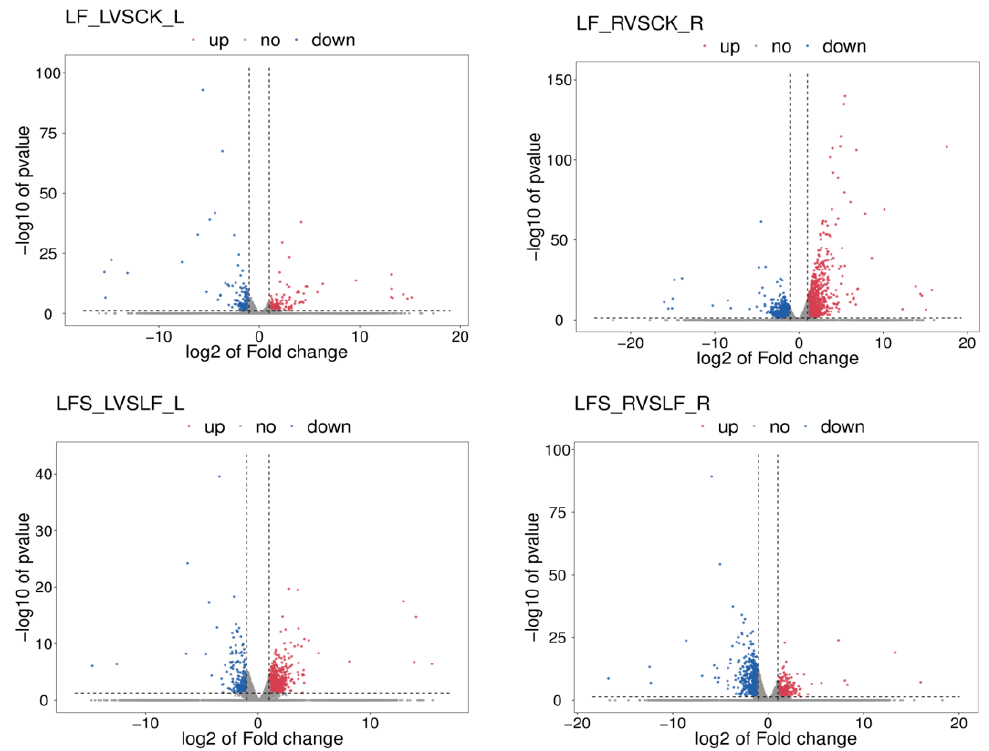
Figure 1. Volcano maps of expression differences. The horizontal coordinate represents the different expression fold changes of the gene in different samples, and the vertical coordinate represents the statistical significance of the difference in the gene expression change. LF_L vs. CK_L, Low Fe_Leaf sample vs. Control_Leaf sample; LF_R vs. CK_R, Low Fe_Root sample vs. Control_Root sample; LFS_L vs. LF_L, Low Fe + Spd_Leaf sample vs. Low Fe_Leaf sample; LFS_R vs. LF_R, Low Fe + Spd_Root sample vs. Low Fe_Root sample.